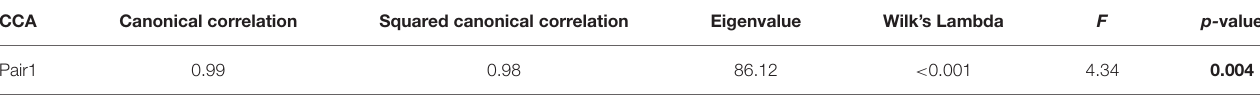
TABLE 4 | Significance of CCA variate pairs in youth with PBD.